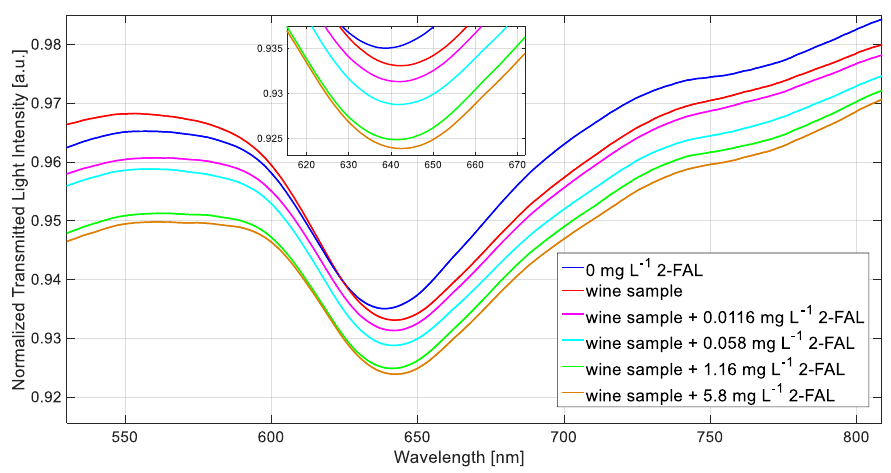
Figure 7. SPR spectra obtained by the SPR-MIP sensor in wine sample.